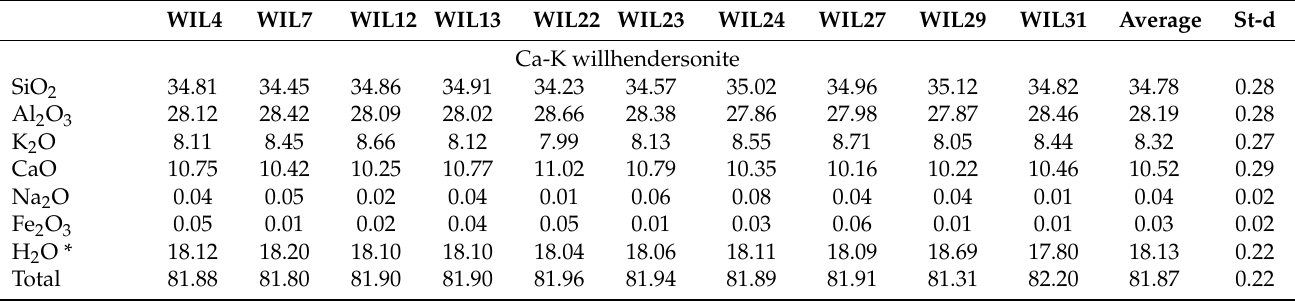
Table 3. Representative chemical compositions of Ca-K willhendersonite from Lessini Mounts. * The H 2 O content is calculated by difference to 100; Mg, Sr, and Ba were checked but were always below the detection limit; E% is the balance error of the electrical charges: [Al − (K + 2Ca)]/(K + 2Ca); R is the tetrahedral content (Si/(Si + Al)) and St-d is standard